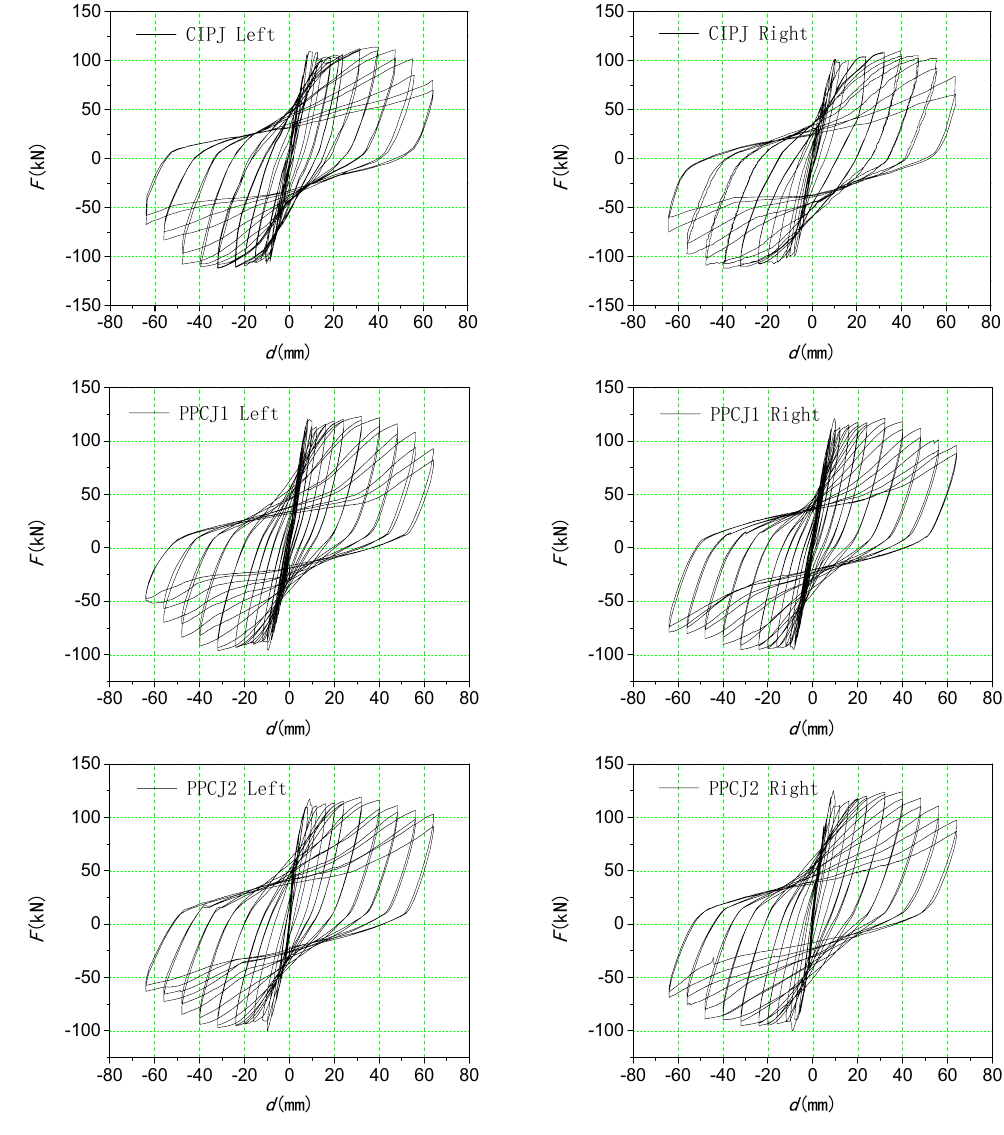
Figure 16. Hysteresis curves of the three joints.